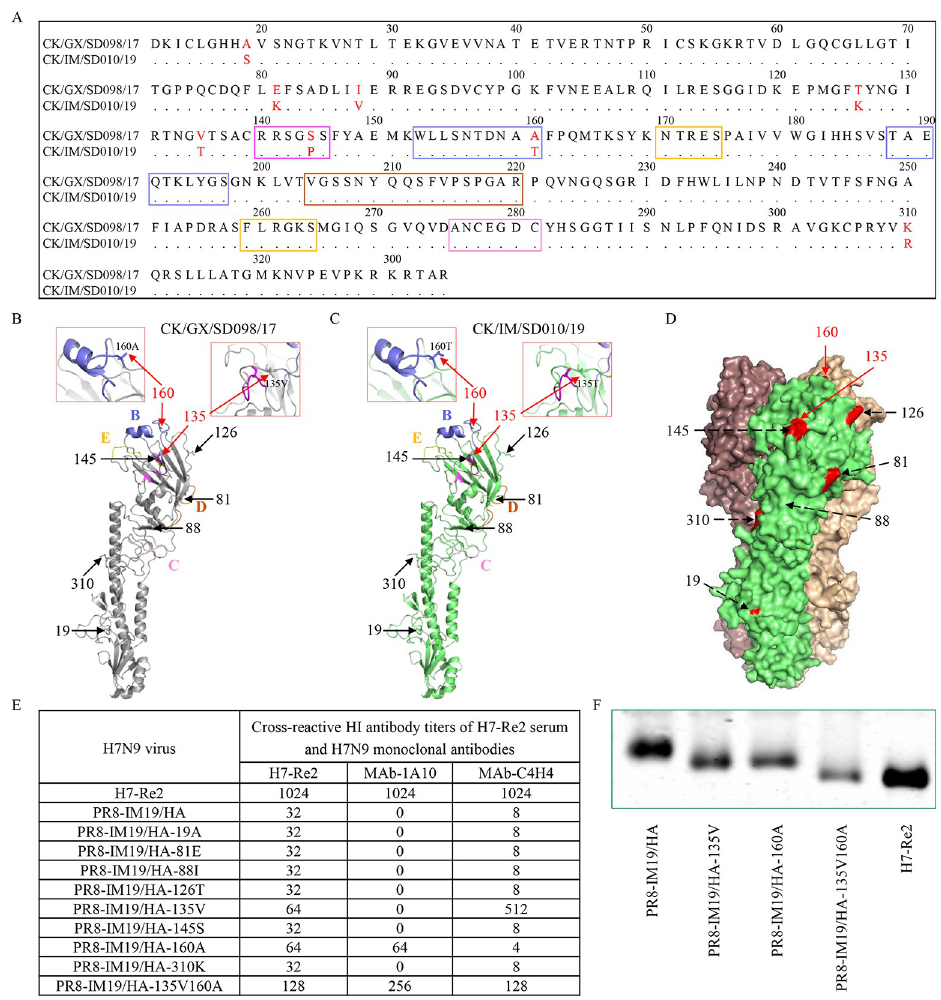
Fig 6. Key mutations in HA that contributed to the antigenic drift of the 2019 H7N9 viruses. (A) Amino acid differences in the HA1 protein of the representative H7N9 viruses CK/GX/SD098/17 and CK/IM/SD010/19. The key amino acids in the head of the HA1 trimer that differ between the two viruses are shown in red. The colored boxes show different antigenic regions (site A to site E). The 2D structure of the HA1 protein of CK/GX/SD098/17 (B) and CK/IM/SD010/19 (C), and the 3D structure of the HA1 protein of CK/GX/SD098/17 (D) were obtained by using SWISS-MODEL; images were drawn with Pymol software. The numbers show the positions of the key amino acid in the head of the HA1 trimer that are different in the representative viruses. (E) HI titers of different H7N9 mutants against H7-Re2 antiserum and H7N9 monoclonal antibodies. (F) Mobility of H7N9 avian influenza HA1 protein analyzed by SDS-PAGE and Western